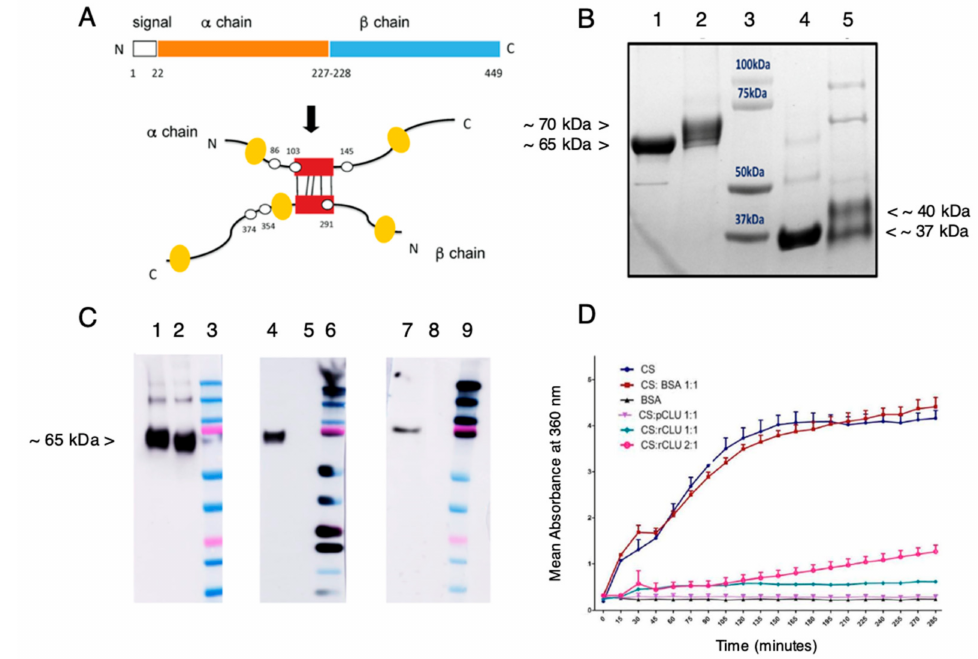
Figure 4. Expression and characterization of GMP-compatible rhCLU. ( A ) CLU Structure. The secretory signal peptide is proteolytically cleaved from the precursor polypeptide chain and sub- sequently the chain is cleaved again between residues Arg227–Ser228 to generate an α -chain and a β -chain. These are assembled in anti-parallel fashion to generate a heterodimeric molecule in which the cysteine-rich centers (red boxes) are linked by five disulfide bonds (black rectangles) and flanked by five predicted amphipathic α -helices (yellow boxes). Amino acid numbering for the N- and C-termini, signal peptide, cleavage site, and predicted sites for N-linked glycosylation are indicated (white spots). ( B ) Processing and Purity. Shown is a Coomassie blue-stained SDS-PAGE. Lane 1: nonreduced pCLU; Lane 2: non-reduced rhCLU- α C-H2S; Lane 3: molecular size standard in kDa; Lane 4: pCLU reduced using β -mercaptoethanol; Lane 5: rhCLU- α C-H2S reduced using β -mercaptoethanol. ( C ) Identity. Shown are Western blots. Lanes 2, 5, 8: non-reduced pCLU; Lanes 3, 6, 9: Molecular size standard. The upper pink band is 75 kDa. Left Panel. CLU antibody probe. Middle Panel. Strep tag antibody probe. Right Panel. Hexahistidine tag antibody probe. Lanes 1, 4, 7: non-reduced rhCLU- α C-H2ST. ( D ) Molecular Chaperone Activity. The client protein, CS (citrate synthase), was heated to 43 ◦ C to induce misfolding and aggregation. rhCLU- α C-H2S or pCLU were mixed with the client at two molar ratios: 1:1 or 2:1, client to chaperone. The negative control, bovine serum albumin (BSA), was assessed in parallel. Aggregation of the client was measured over a 200-min time course as absorbance at 360